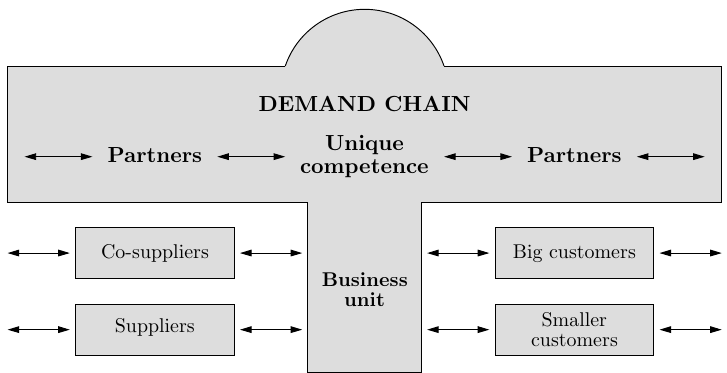
Figure 11: Different relationships in a network of supply chains, ranging from loose coalitions to interdependent partnerships, i.e. demand